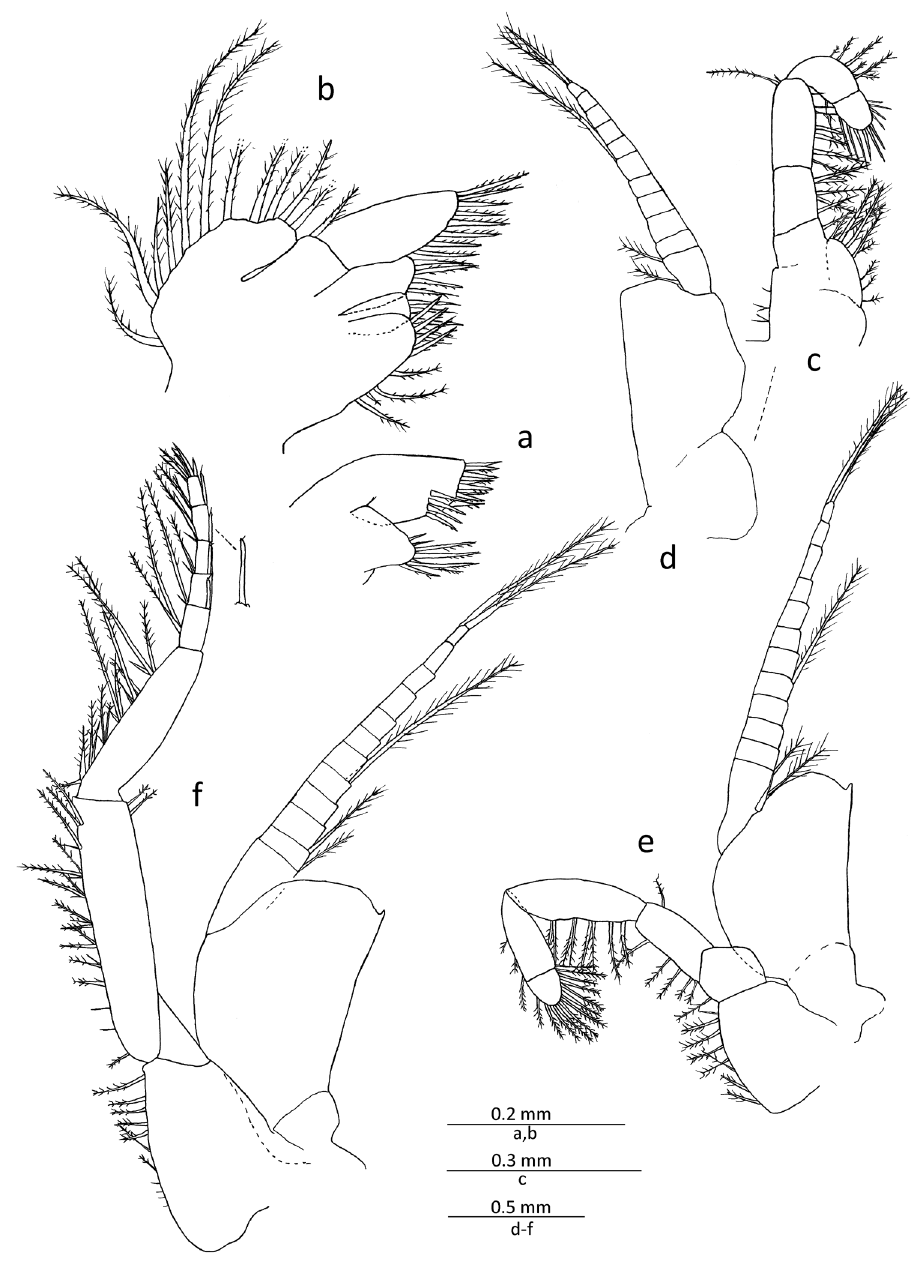
Figure 3. Gastrosaccus lombokiensis sp. n., paratype male (TL ca. 7.5 mm): a right maxillule, external view b right maxilla, external view c right endopod of first thoracic limb, external view d right exopod of first thoracic limb, external view e right second thoracic limb, internal view f right third thoracic limb, posterior